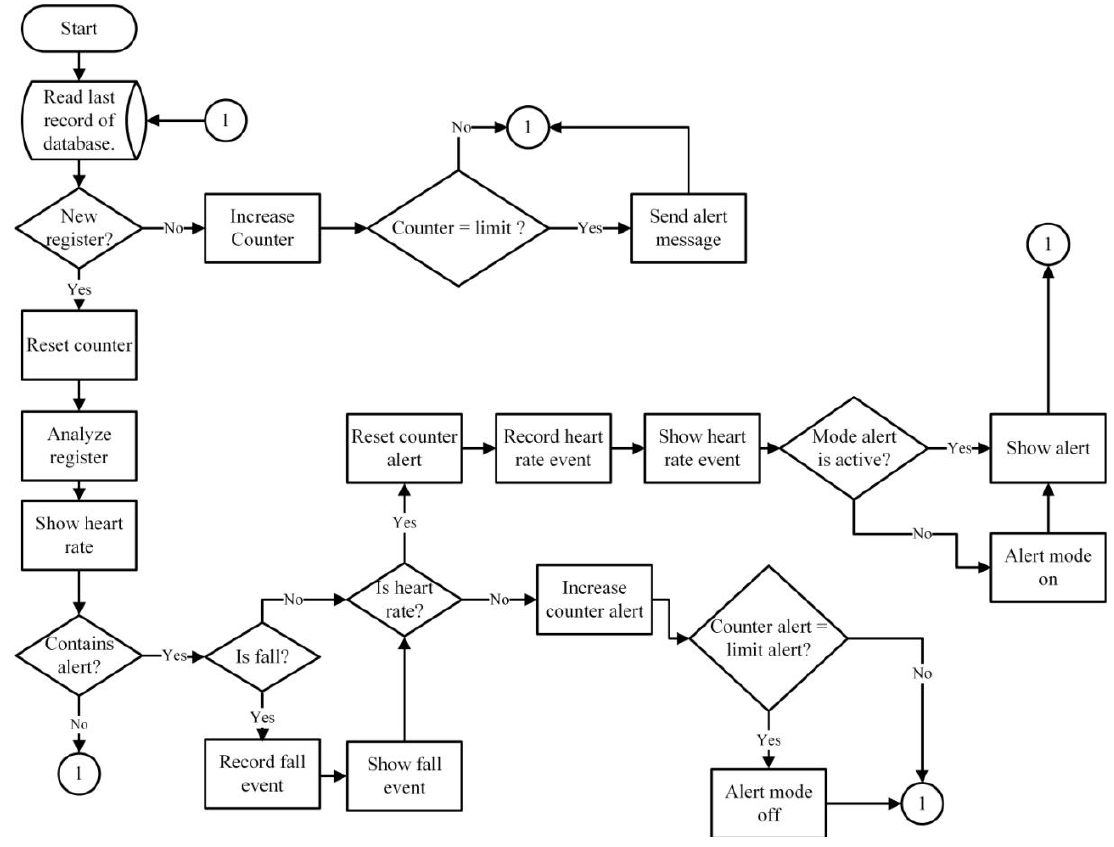
Figure 6. Web interface and alerts flow